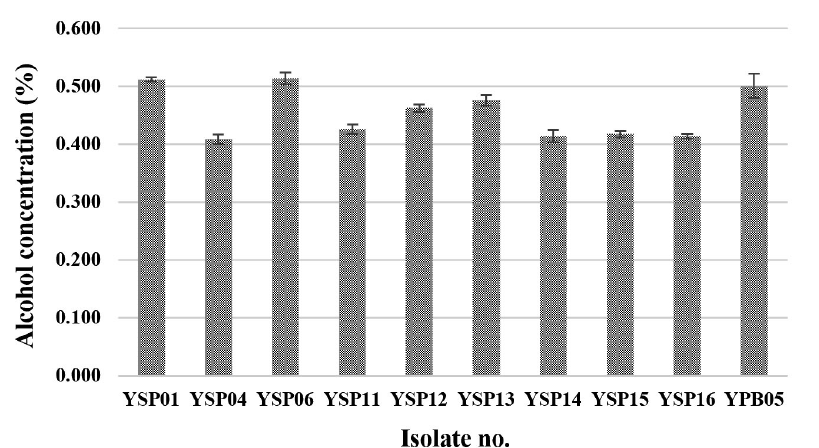
Fig. 3. Alcohol contents of ten yeast isolates fermented in 10% glucose medium under a static condition for 3 days